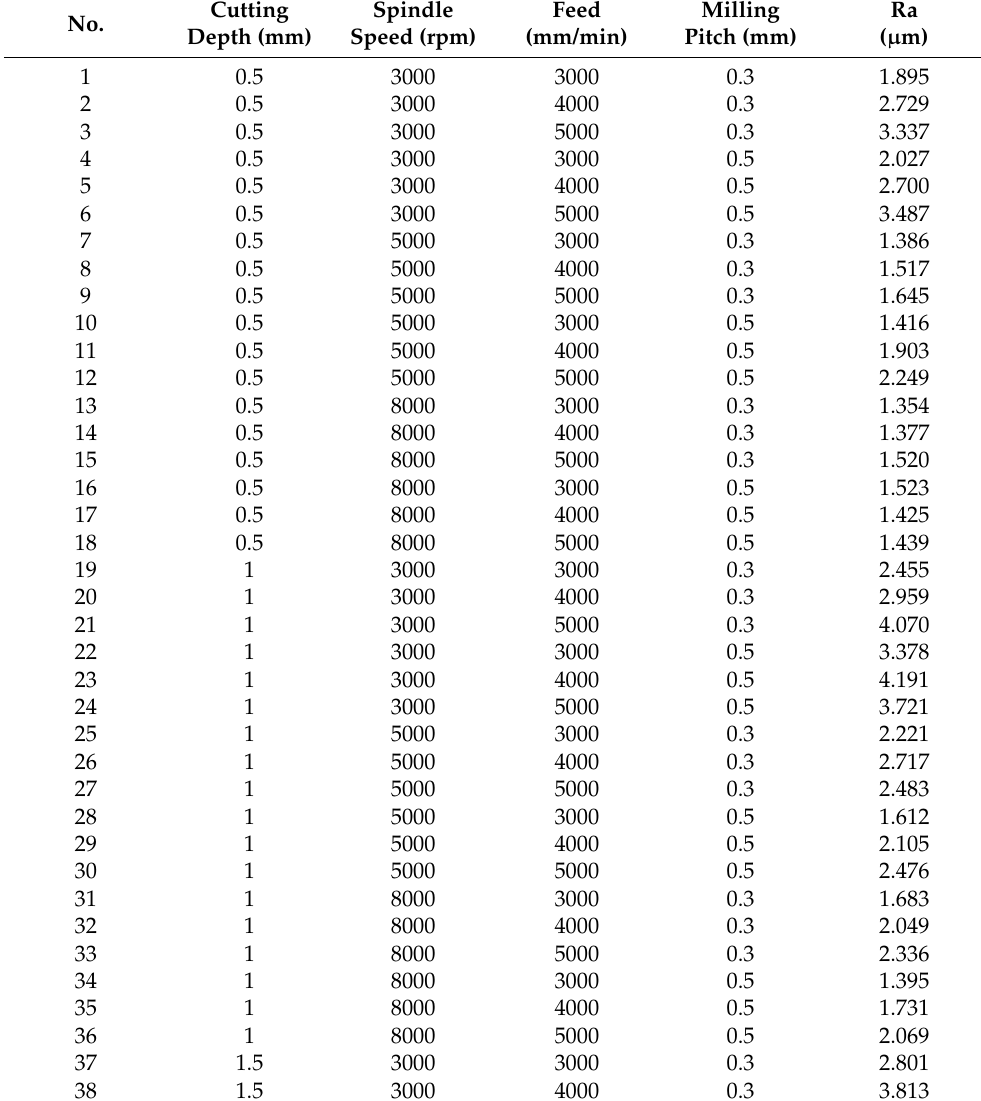
Table 5. Experimental orthogonal